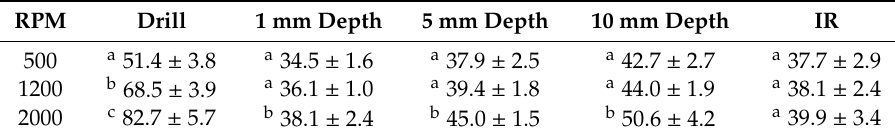
Figure 3. ( a ) The mean values of thermal change during drilling at 500 rpm; ( b ) at 1200 rpm; ( c ) at 2000 rpm. Table 1. Mean values of peak temperature by drill speed and measuring depth.